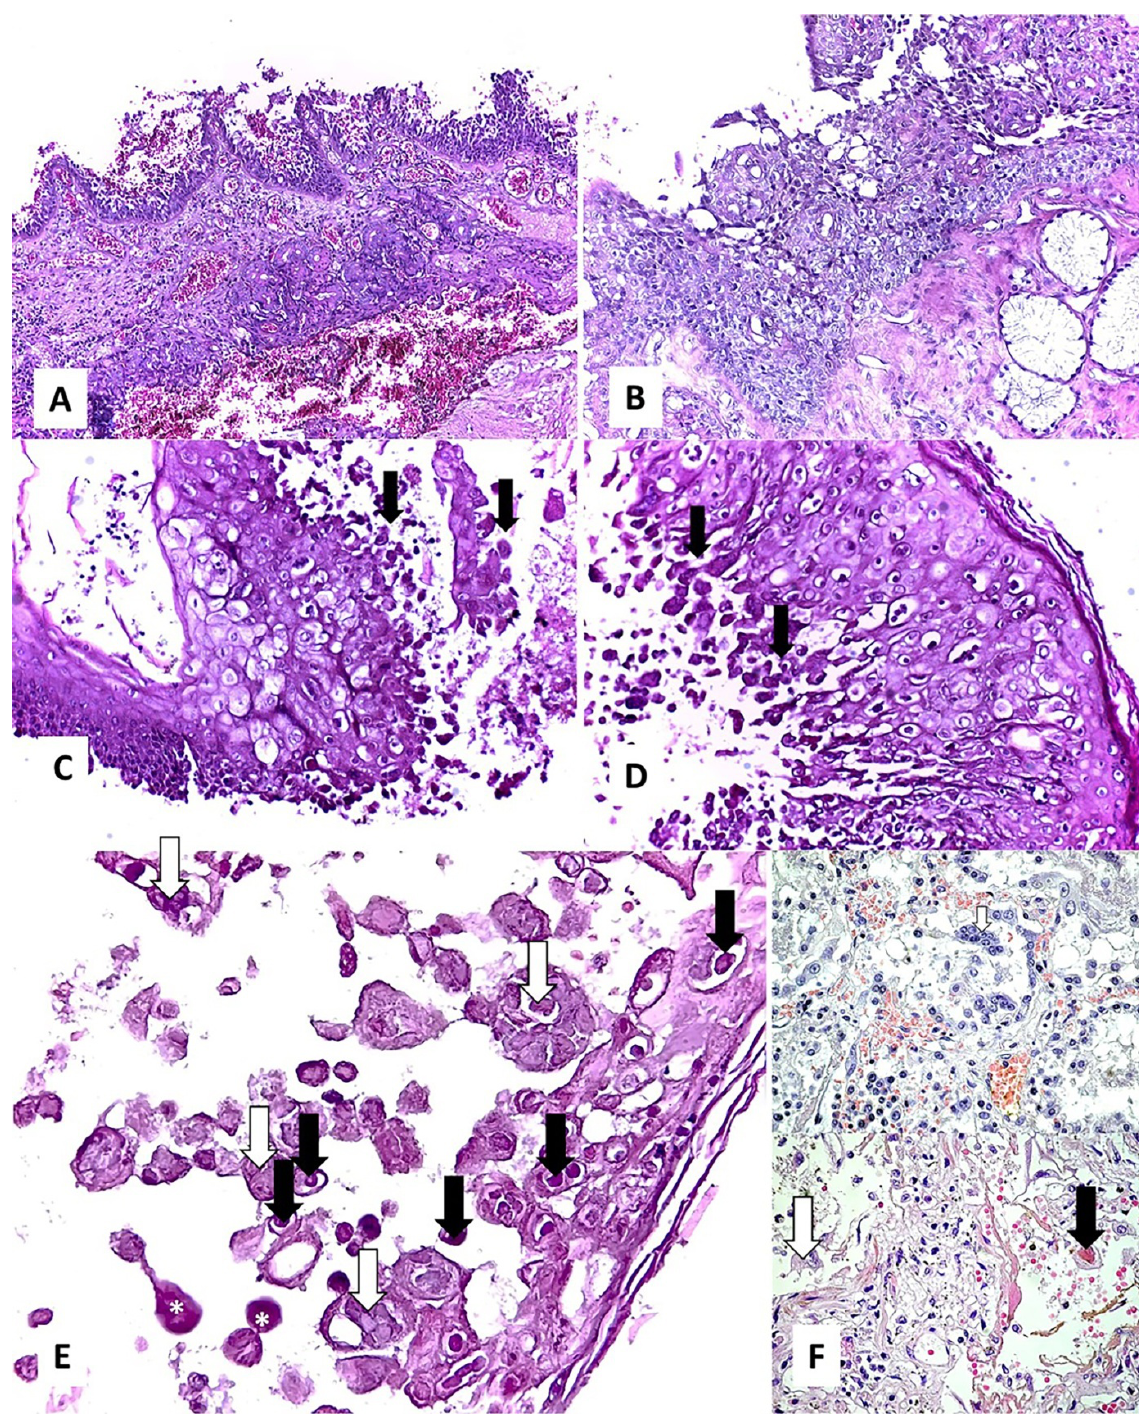
Figure 2. Histopathological findings in the nasal mucosa of COVID-19 patients: ( A , B )—lymphocytic inflammation in the lamina propria, regardless of the absence (( A ), HE ob. 10×) or presence (( B ), HE ob. 20×) of squamous metaplasia; ( C , D )—squamous metaplasia accompanied by a viral cytopathic effect in the hyperplastic basal layer (arrows) (HE ob. 20×); ( E )—multinucleated giant cells (white arrows), prominent eosinophilic nuclear inclusion (black arrows) with cytomegaly, and some cells in induced necrobiosis (*) with nuclear lysis (HE ob. 40×); ( F )—similar effect in alveolar macrophages in COVID-19 pneumonia (personal collection) (HE ob. 40×).